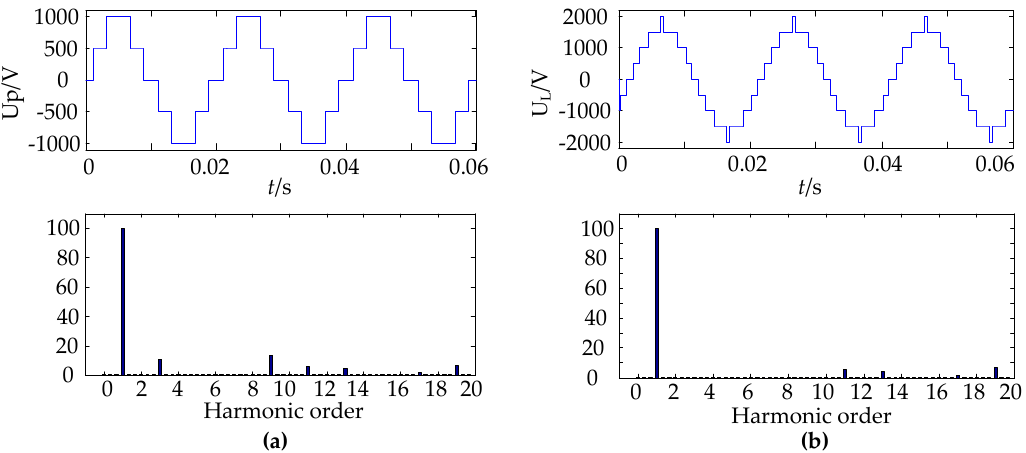
Figure 8. Simulation and analysis with a 0.95 modulation index: ( a ) waveforms of phase voltage and its spectrum analysis; ( b ) waveforms of line voltage and its spectrum analysis.